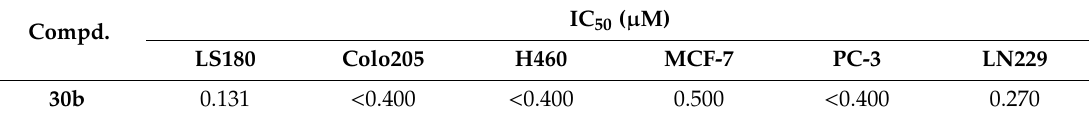
Table 10. Cytotoxic activity of 30b against tumor cell lines determined by MTT assay. Compd.